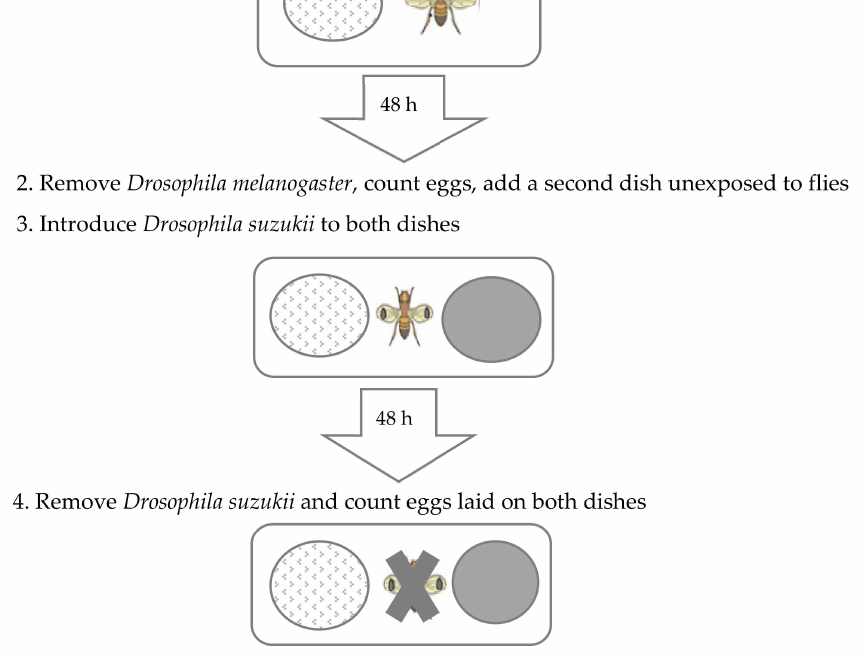
Figure 1. Schematic representation of the oviposition choice test experiment where Drosophila suzukii were given a choice to oviposit on cornmeal media dish that had been pre-exposed to D. melanogaster versus media that had never been exposed to D. melanogaster (blank) (adapted from Shaw et al.